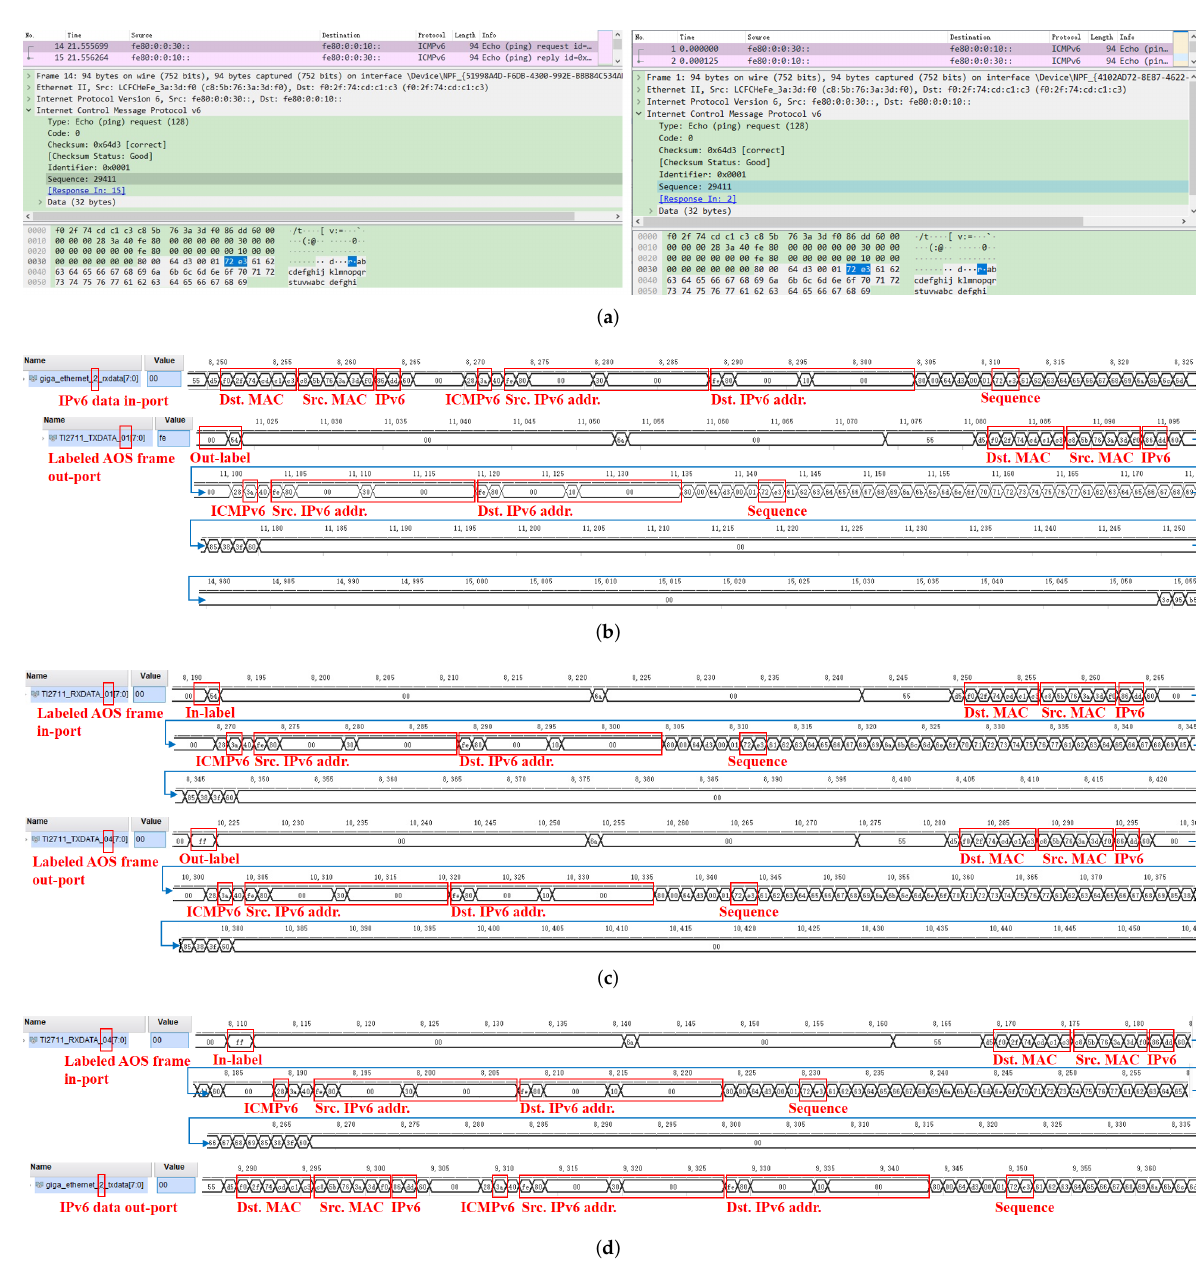
Figure 27. The label-based AOS frame switching in backward label switching path under the circumstances of uni-directional link between node vx_simulator_01 (uni-directional sending) and node vx_simulator_02 (uni-directional receiving) in the semi-physical platform. ( a ) The IPv6 data transmitted from node vx_simulator_03 (egress LER, SCID 3) to node vx_simulator_01 (ingress